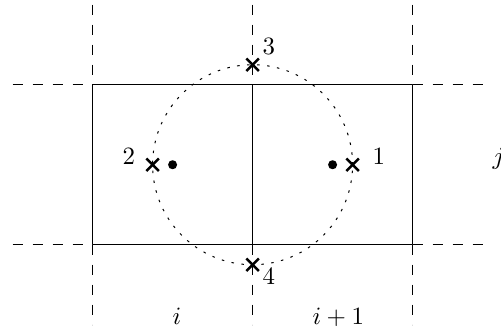
Figure 1. Intersection of the characteristic surfaces with time level ( n )